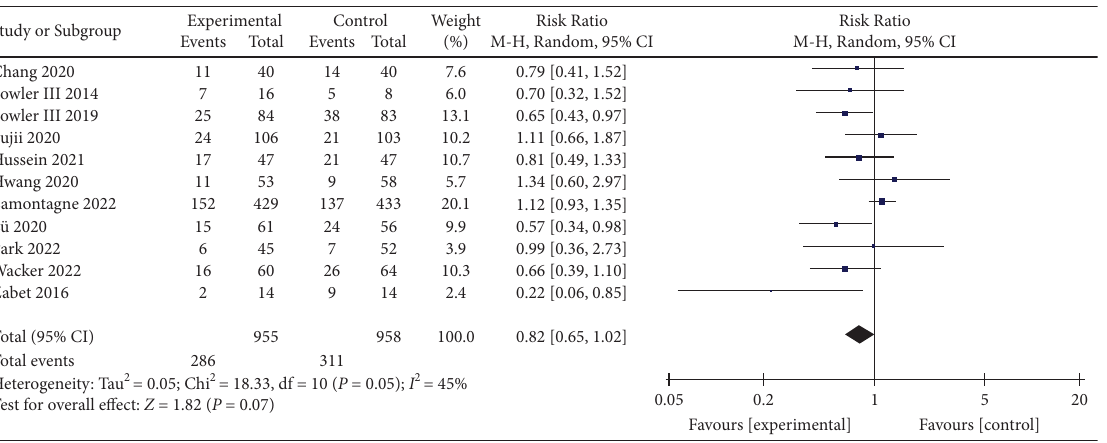
Figure 5: Forest plots for the efect of vitamin C on the 28-day mortality.